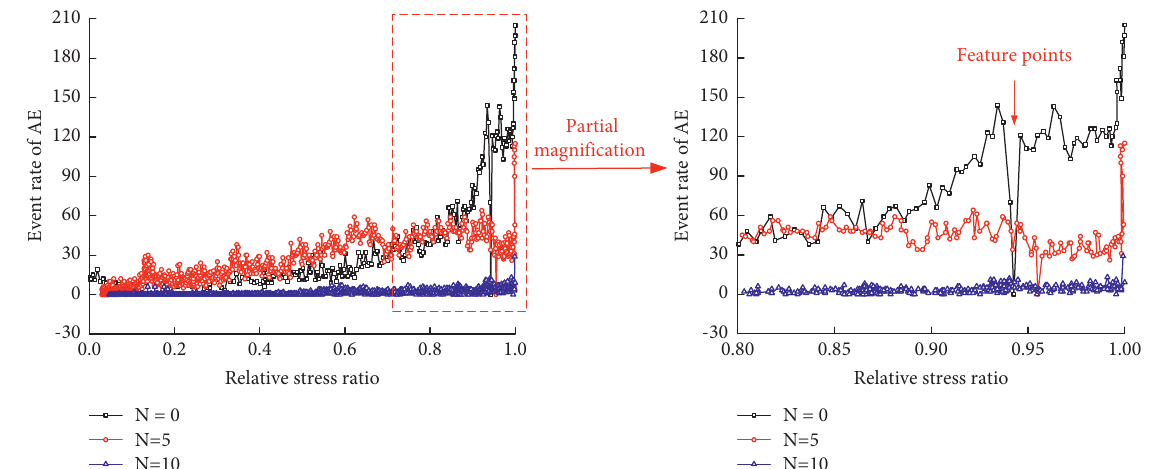
Figure 12: The overall quantity change in the number of acoustic emission events during the failure of weakly cemented sandstone under different dry-wet cycles.